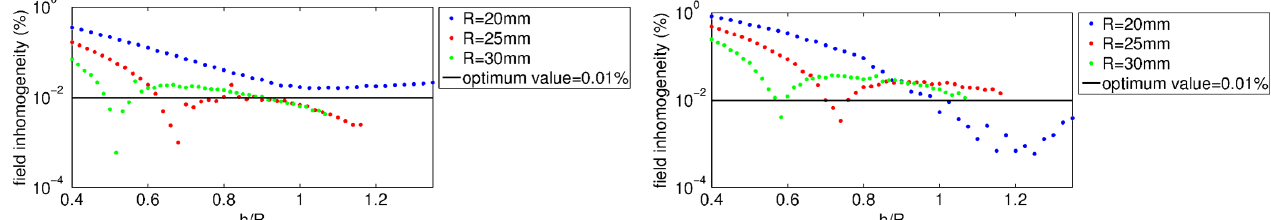
FIG. 8. Odd mode field inhomogeneity (logarithmic scale) over 1 mm radius versus h = R, for flat electrodes (left) and type (e) half- moon electrodes (right). For 25 and 30 mm radius, field homogeneity simulations produced invalid results for values of h = R ≥ 1 . 1 .